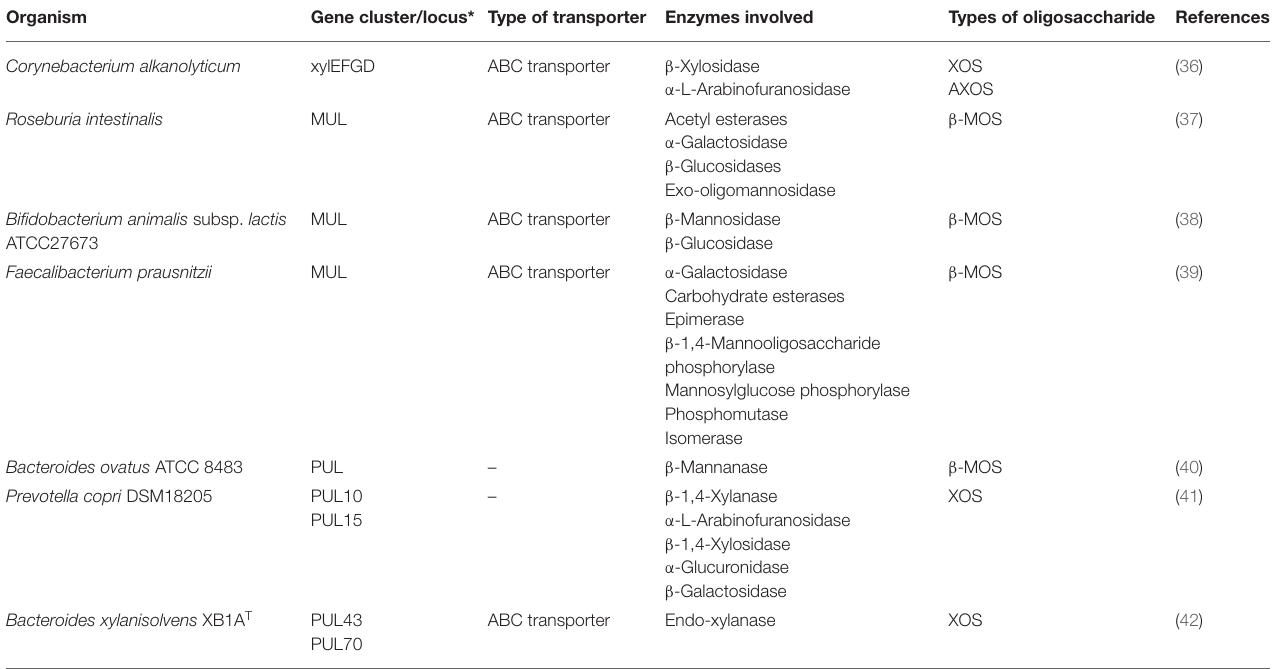
TABLE 3 | Gene clusters and enzymes involved in polysaccharide utilization by microorganisms present in the